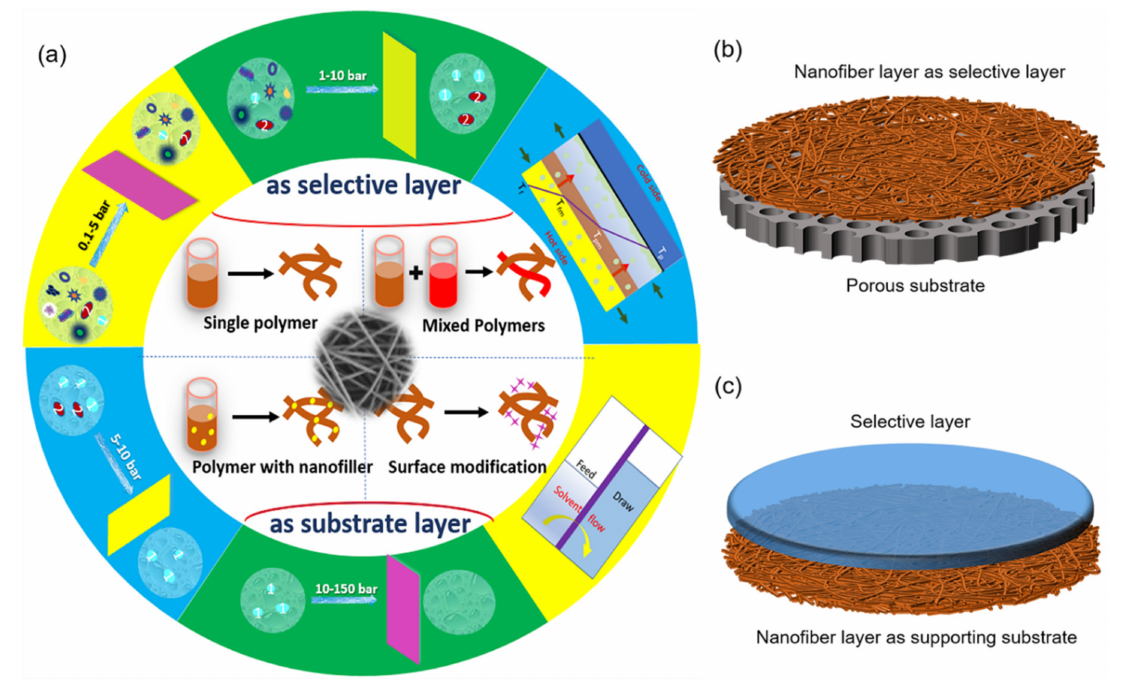
Figure 1. ( a ) Preparation and application of ENMs; ( b , c ) ENMs schematic images of two roles of nanofiber layers: served as selective layer ( b ) and supporting substrate ( c